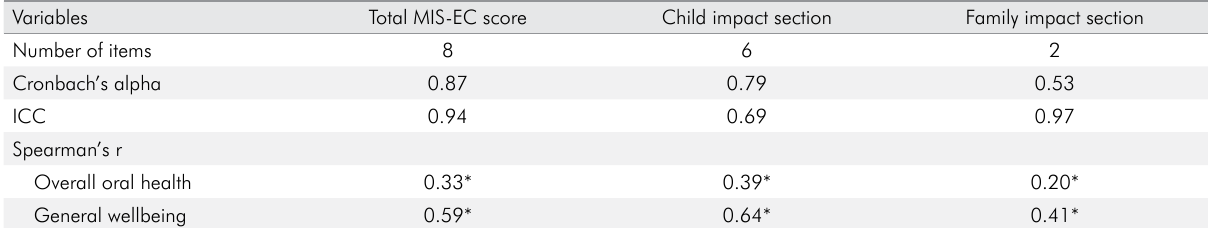
Table 3. Internal consistency and convergent validity of MIS-EC.